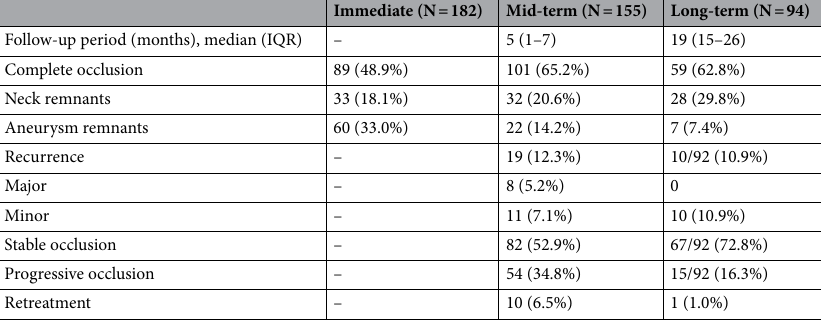
Table 2. Angiographic results immediately after WEB embolization, at mid-term follow-up (≤ 12 months) and at long-term follow-up (> 12 months). IQR interquartile